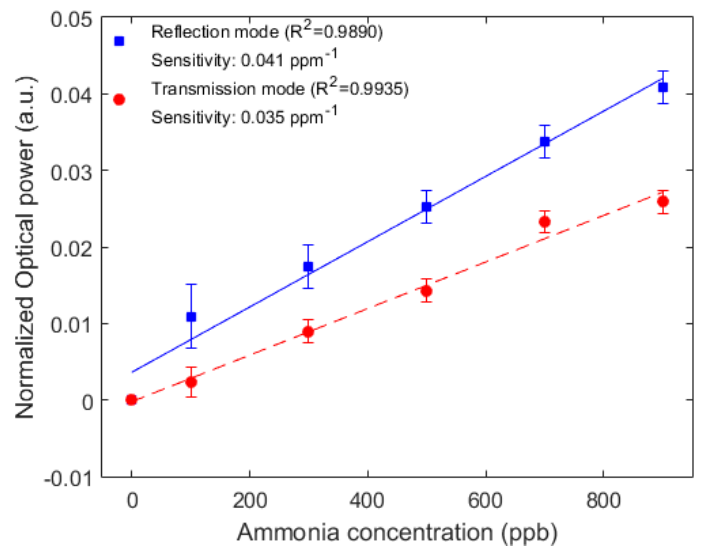
Figure 6. Comparison between the fiberoptic probe responses in the transmission and reflection mode as a function of the ammonia concentration.